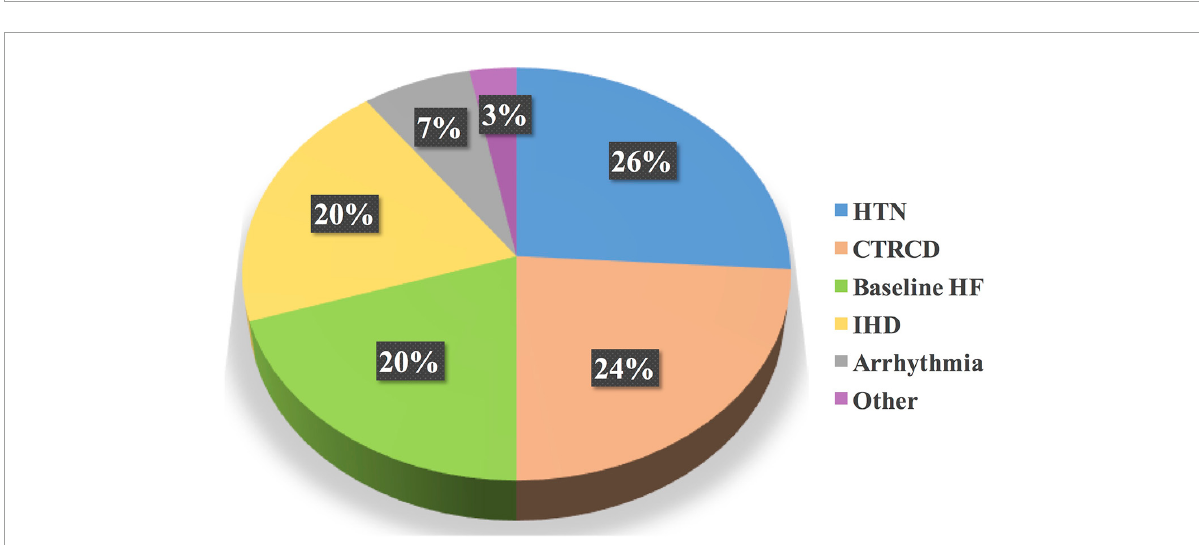
FIGURE7 Most common CVRF/CVD treated initially by the cardiology pharmacist. Based on the total drug interventions by the cardiology pharmacist, HTN, followed by CTRCD, were the main CVRF/CVD cases treated initially by the cardiology pharmacist. CVD, cardiovascular disease; CTRCD, cancer therapy-related cardiac dysfunction; CVRF, cardiovascular risk factor; HF, heart failure; HTN, hypertension; IHD, ischemic heart